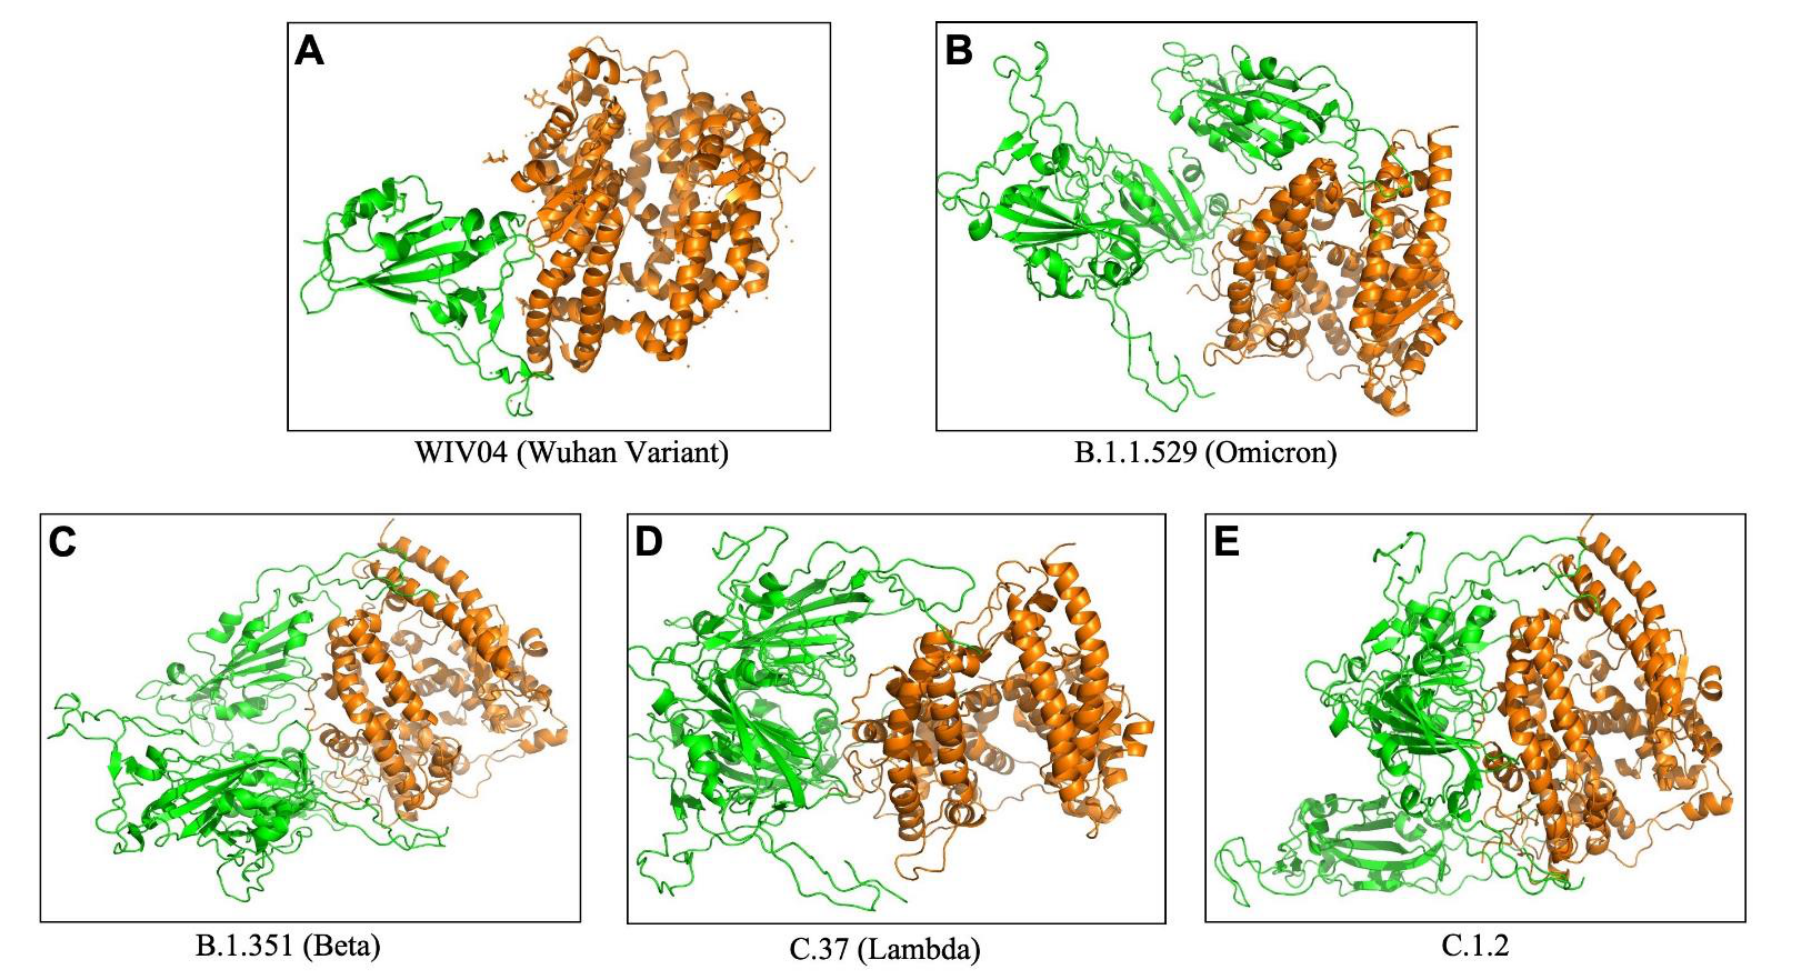
Figure 3: The 3D binding interface of S protein RBD (Green) and hACE2 (Orange) complex obtained from